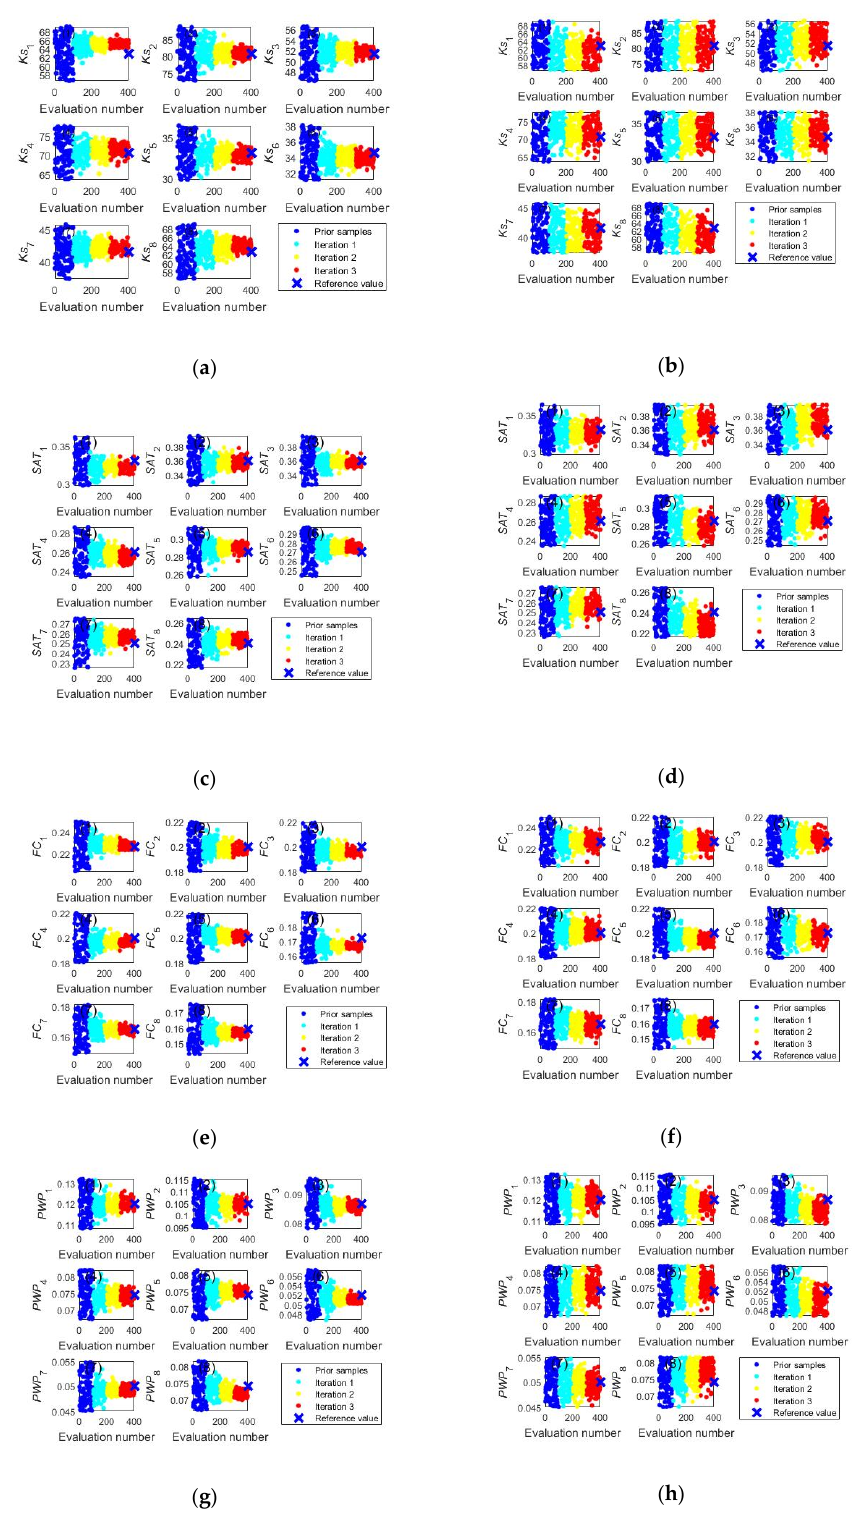
Figure 2. Trace plots of soil hydraulic parameters obtained by the ILUES ( left column ) and ESMDA ( right column ) algorithms. The blue cross symbol at the right side of each figure signifies the re- ferred value of each parameter. ( a ) Saturated hydraulic conductivity derived by ILUES; ( b ) Saturated hydraulic conductivity derived by ESMDA; ( c ) Saturated soil water content derived by ILUES; ( d ) Saturated soil water content derived by ESMDA; ( e ) Field capacity derived by ILUES; ( f ) Field capacity derived by ESMDA; ( g ) Wilting point derived by ILUES; ( h ) Wilting point derived by